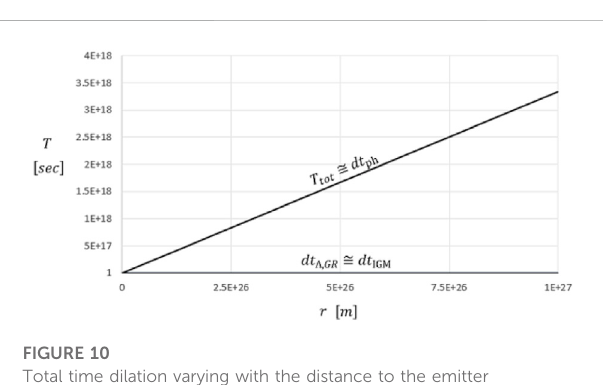
FIGURE 10 Total time dilation varying with the distance to the emitter experienced by any observer in the Cosmos. The graph has been calculated for a matter density in the Universe equal to 3E-28 kg/m 3